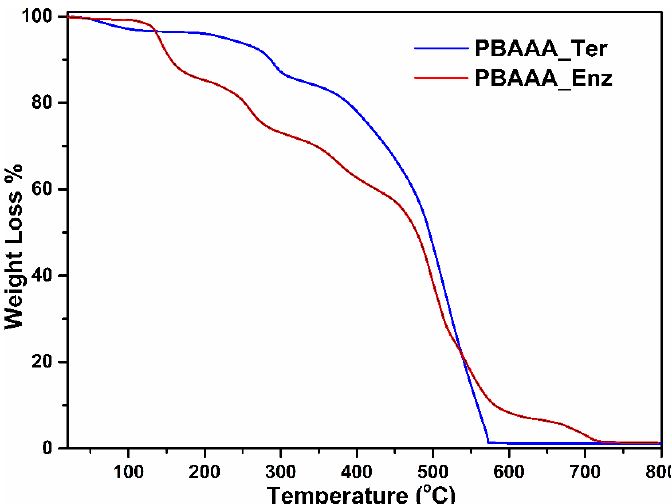
Figure 7. TGA curve of the PBAAA_Ter (blue line) and PBAAA_Enz (red line) performed in air at a heating rate of 10 °C min − 1 between 30 °C and 800 °C.